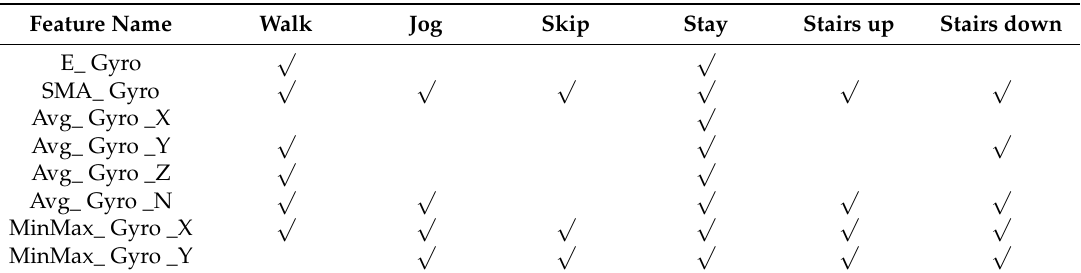
The list of selected features due to the different activity datasets in the only gyroscope